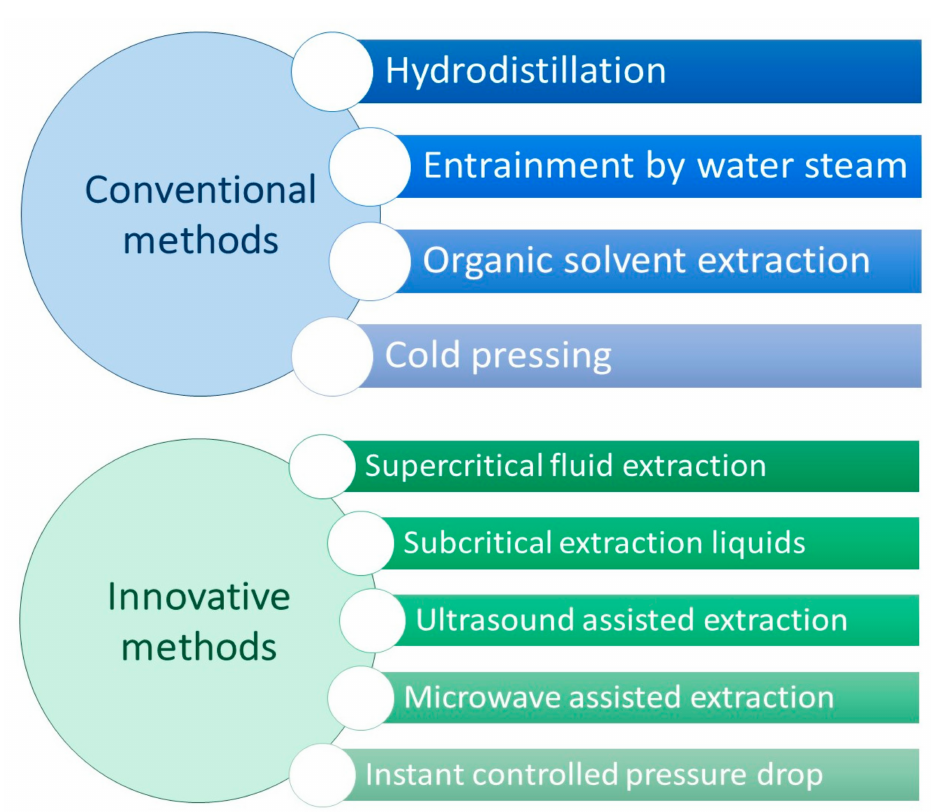
Figure 1. Schematic summary of conventional and innovative extraction